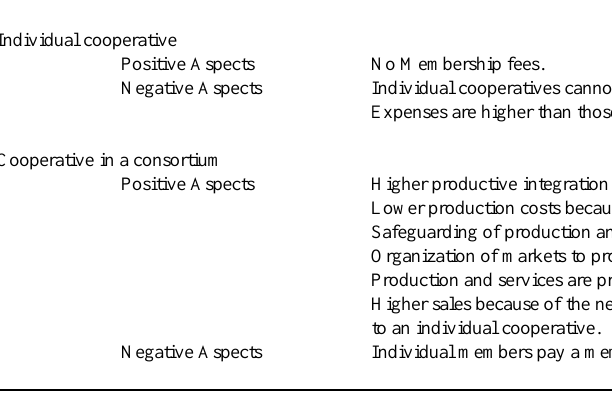
Table 4 . Positive and negative aspects of an individual cooperative and a cooperative in a corsortium. Individual cooperative Positive Aspects No Membership fees. Negative Aspects Cooperative in a consortium Positive Aspects Higher productive integration. Lower production costs because of better management. Safeguarding of production and marketing process and protection of members against irregularities or abuse. Organization of markets to promote business with advertising. Production and services are promoted with quality trade marks. Higher sales because of the negotiation with external mussel markets of a better bulk price than that offered to an individual cooperative. Negative Aspects Individual members pay a membership